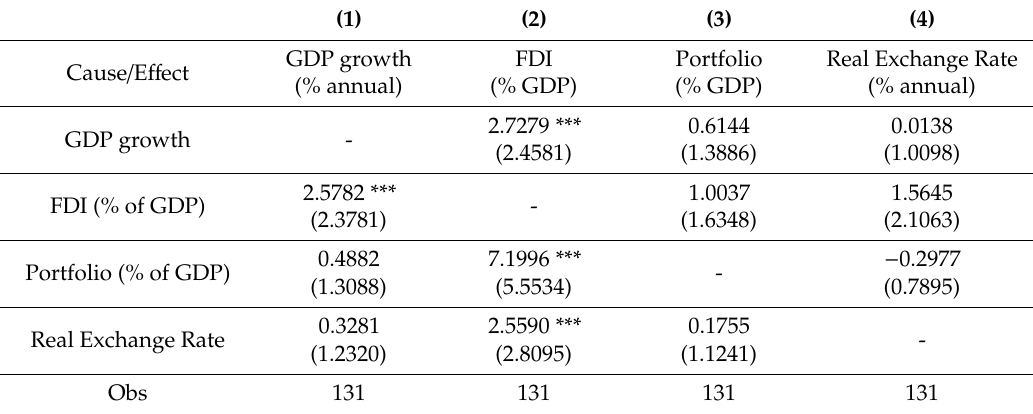
Table 4. Granger bi-directional causality test results: Coe ffi cient is Z-bar and (.) is the W-bar, lags